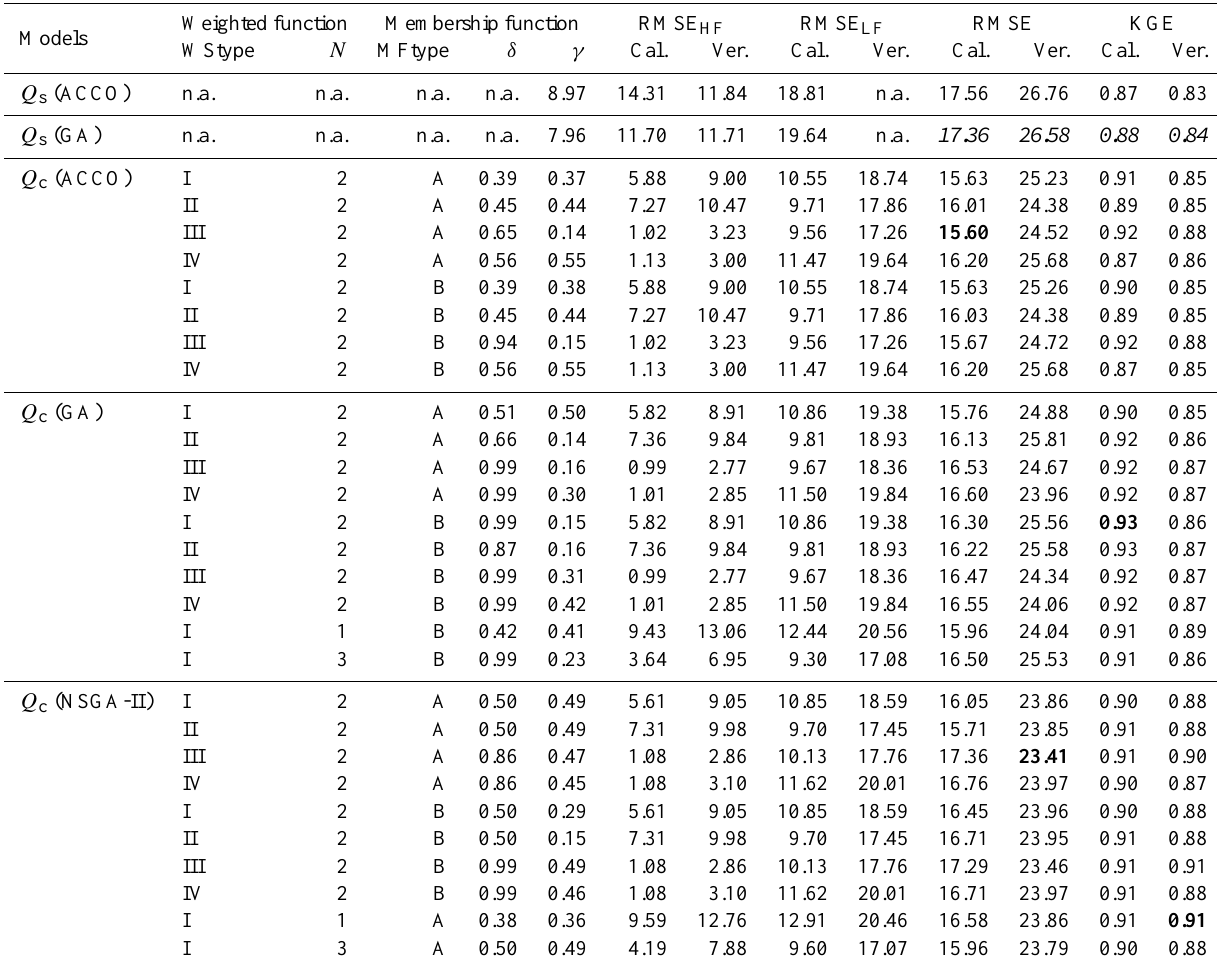
Table 5. Performance of committee models for the Leaf catchment, with possible combinations of the various weighting schemes and membership functions.